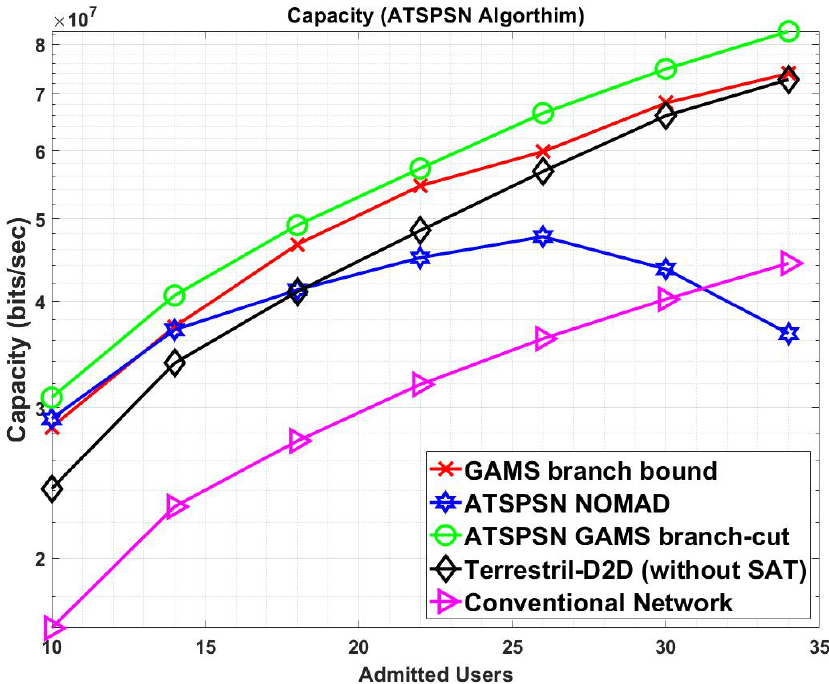
Figure 6. Capacity: NOMAD, Branch cut, Branch